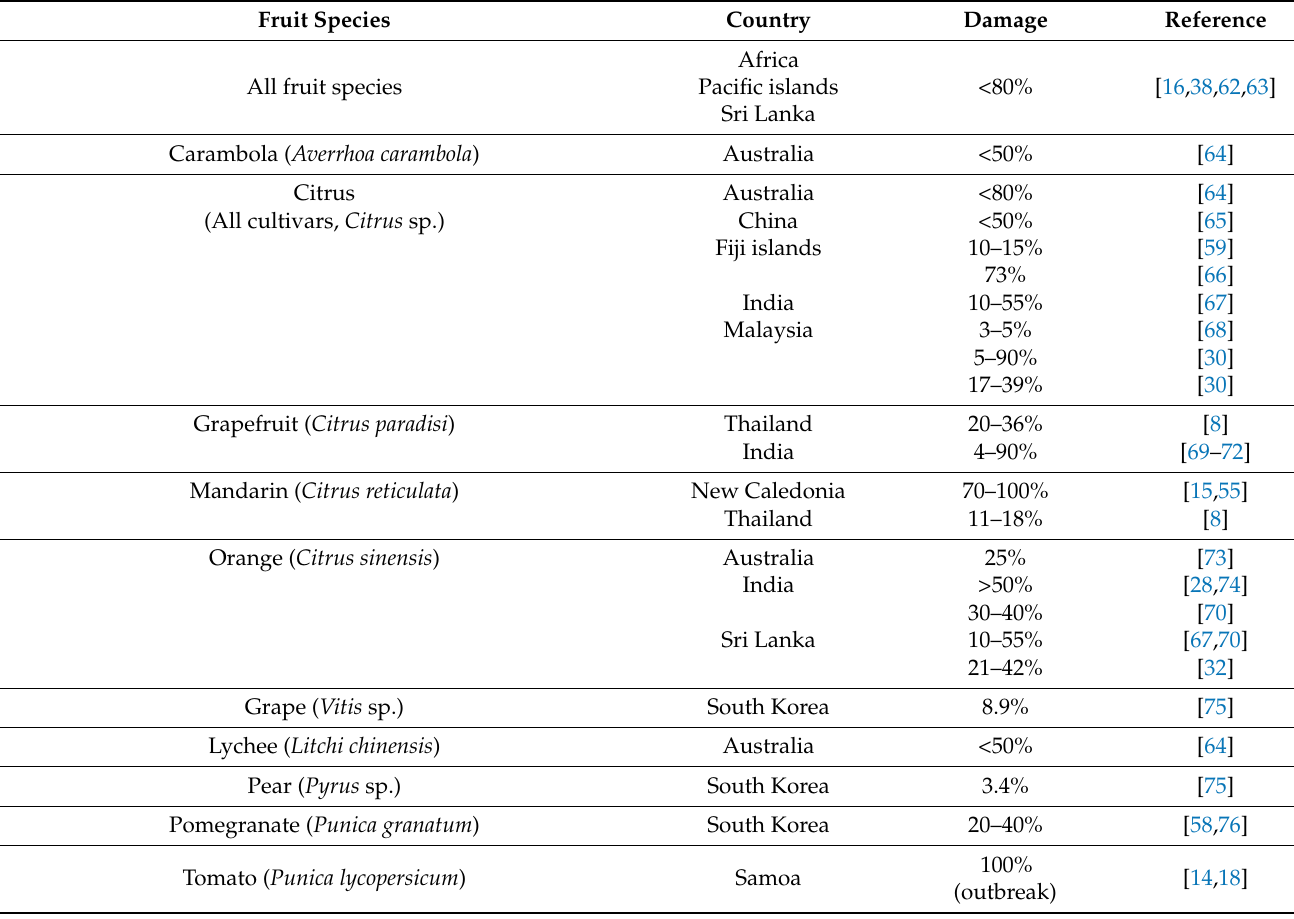
Table 1. Assessment of damage to fruit species for all species of fruit-piercing moth, clearly quoting or including Eudocima phalonia . Damage is defined as a measurable loss of commodity value in terms of quantity, quality or aesthetic appeal of fruits, due to insect